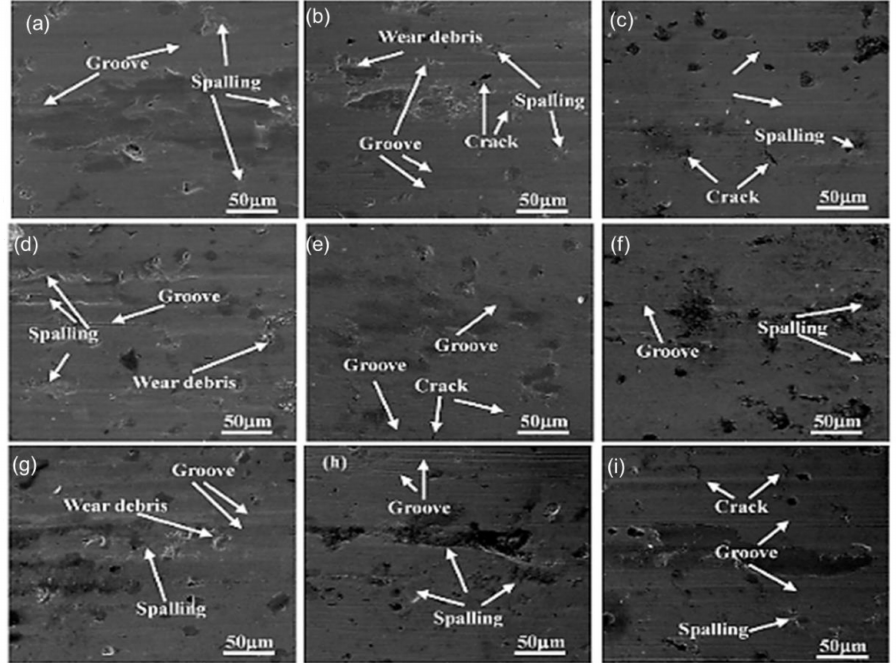
Figure 31. The morphological structures of worn samples austempered at varying temperatures and forces: ( a ) 230 ◦ C, 5 N; ( b ) 230 ◦ C, 10 N; ( c ) 230 ◦ C, 15 N; ( d ) 300 ◦ C, 5 N; ( e ) 300 ◦ C, 10 N; ( f ) 300 ◦ C, 15 N; ( g ) 380 ◦ C, 5 N; ( h ) 380 ◦ C, 10 N; ( i ) 380 ◦ C, 15 N [39].